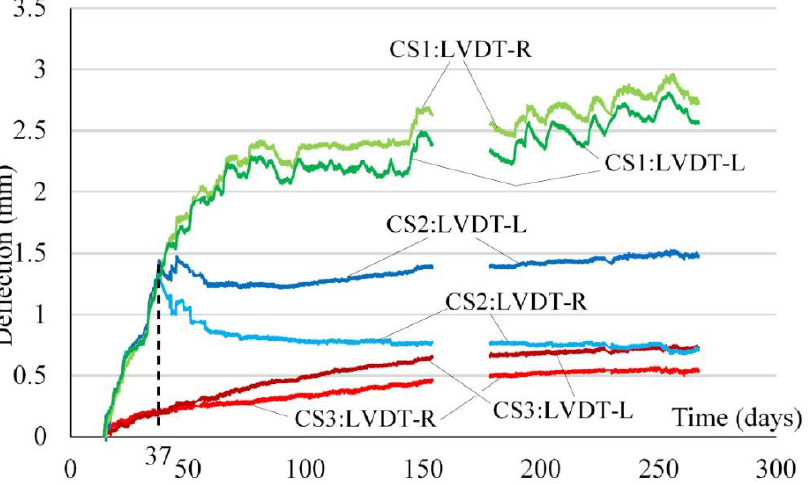
Figure 6. Mid-span deflections measured for the continuous specimens (LVDT-L = mid-span deflec- tion of left span; LVDT-R = mid-span deflection of right span) [53].